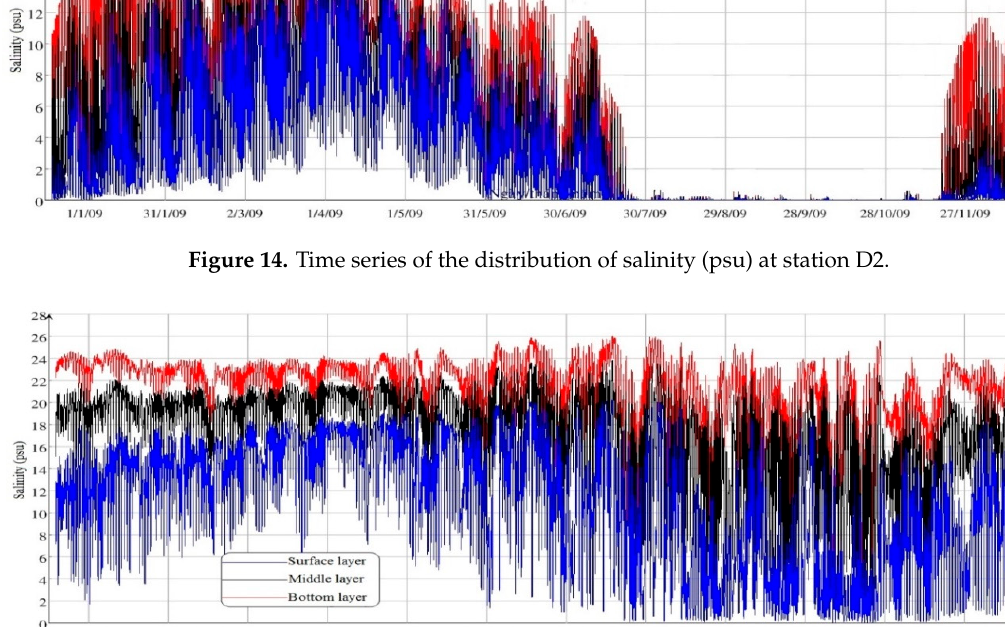
Figure 15. Time series of the distribution of salinity (psu) at station S11.